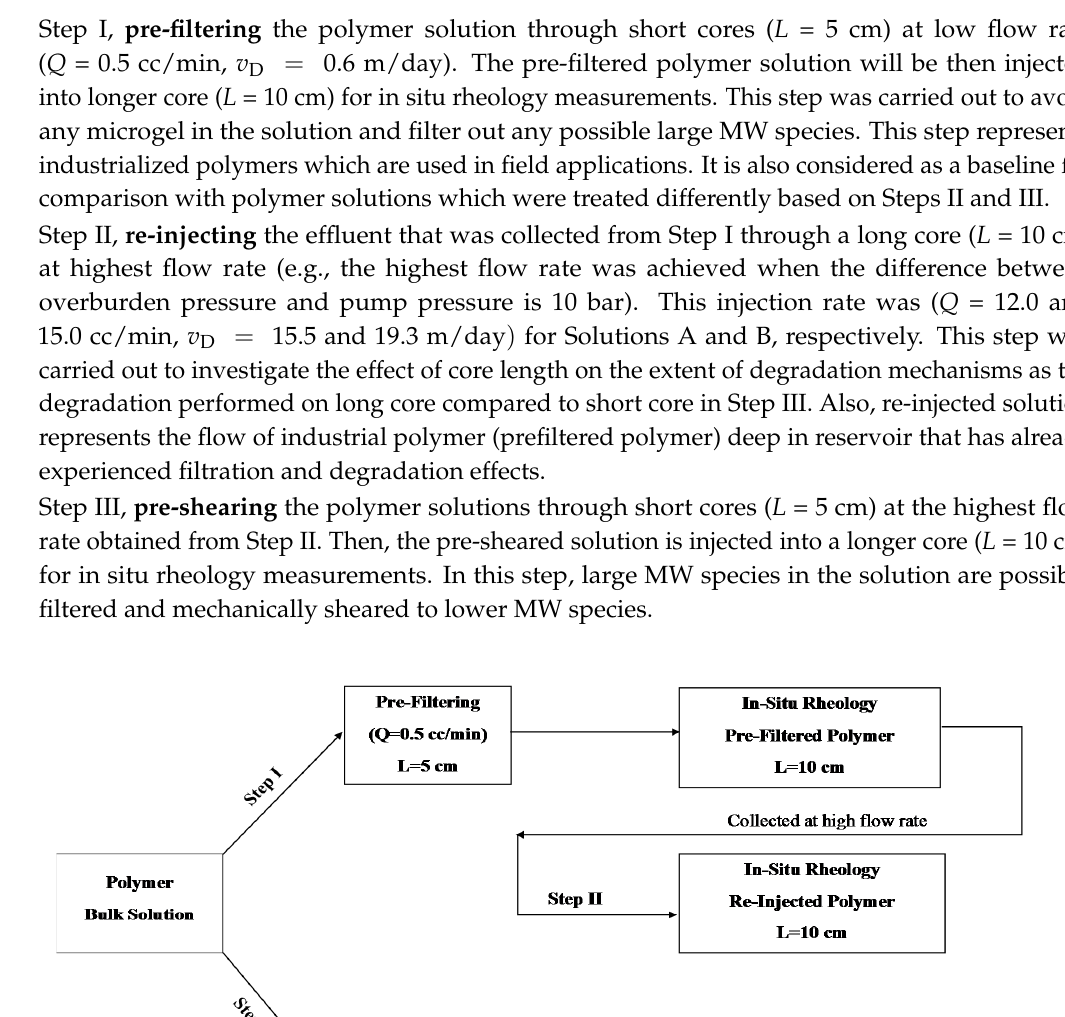
where, Q is injection flow rate, η is fluid viscosity, Δ(cid:1842) is pressure drop across the core, L and A are core length and cross-sectional area, respectively. Note that interstitial velocity ( v ) was obtained from Darcy velocity ( (cid:1874) (cid:2888) ), where (cid:2038) is the porosity of porous media. Polymer solution, after pretreatment, was injected into the core using Quizix pumps at low flow rate ( Q = 0.5 cc/min, (cid:1874) (cid:2888) = 0.6 m/day ) for at least 2 PV to satisfy porous medium polymer adsorption level and achieving stable differential pressure. Then, polymer flow rate was varied in a stepwise manner from the highest to the lowest rate. Each rate step was continued until a stabilized pressure drop across the core was achieved. Resistance factor ( RF ) was calculated as following [3]: